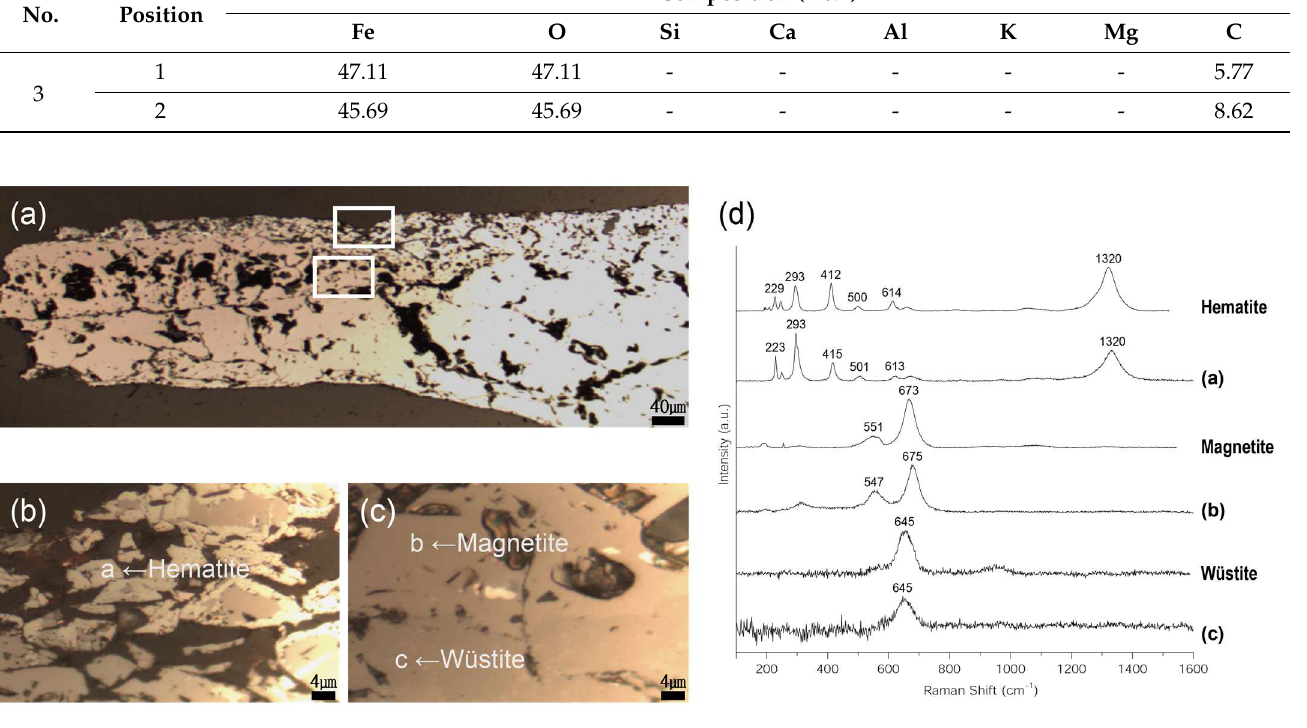
Figure 10. ( a – c ) Position of Raman micro-spectroscopy analysis of flake hammer scale (No. 3); ( a ) rectangle is position of ( b , c ), ( d ) Raman spectrum. Table 4. EDS analysis of flake hammer scale (No.